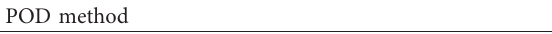
Table 1: The classification of the POD